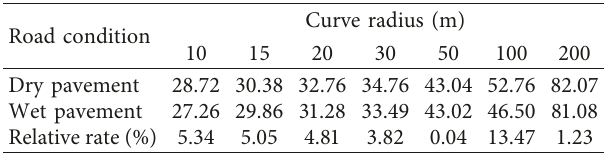
Figure 14: Vertical force varying with braking time: (a) on dry road; (b) on wet road. Table 3: Speed limit under different curve radius (km/h).